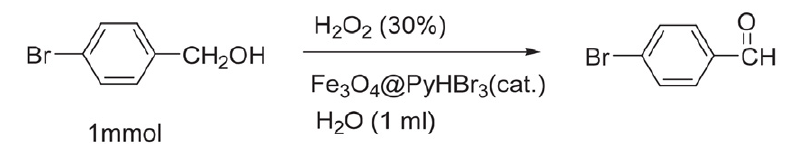
Table1. Optimization of the oxidation of 4-bromobenzyl alcohol by 30% H 2 O 2 . a